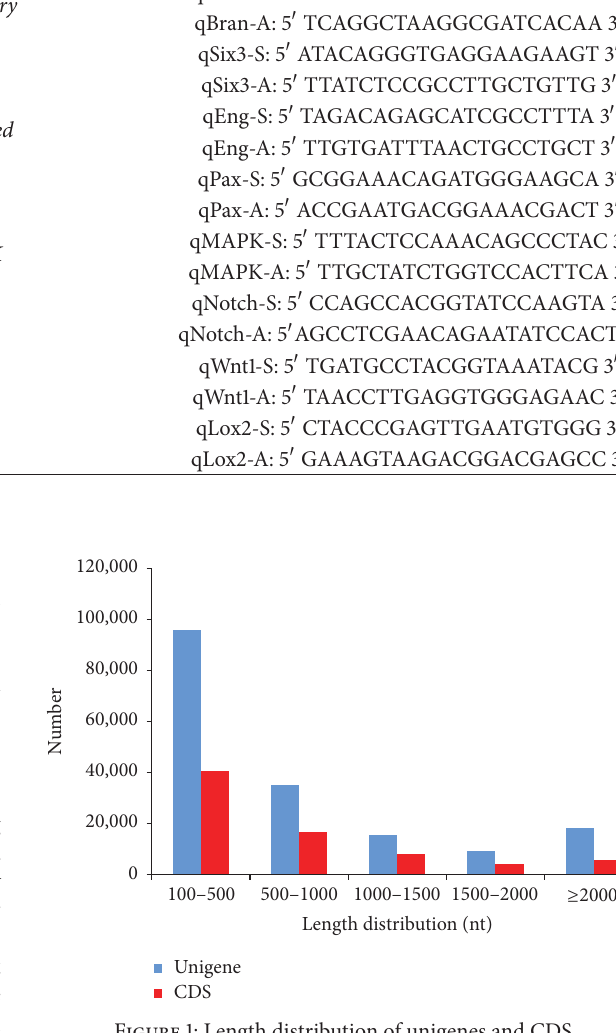
Figure 1: Length distribution of unigenes and